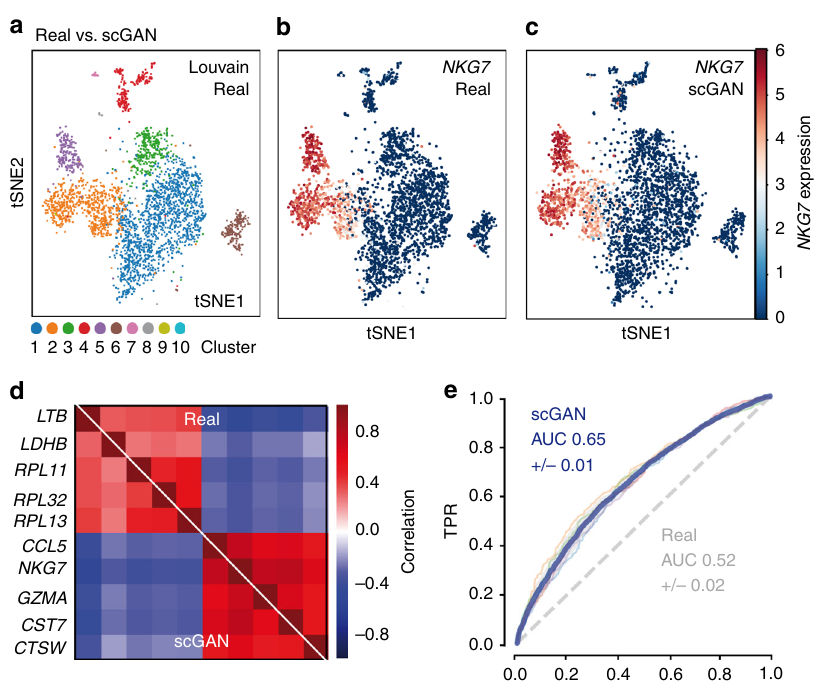
Fig. 1 Evaluation of the scGAN-generated PBMC cells. a – c t-SNE visualization of the Louvain-clustered real cells ( a ) and the NKG7 gene expression in real ( b ) and scGAN-generated ( c ) cells. d Pearson correlation of marker genes for the scGAN-generated (bottom left) and the real (upper right) data. e Cross- validation ROC curve (true positive rate against false positive rate) of an RF classifying real and generated cells (scGAN in blue, chance-level in